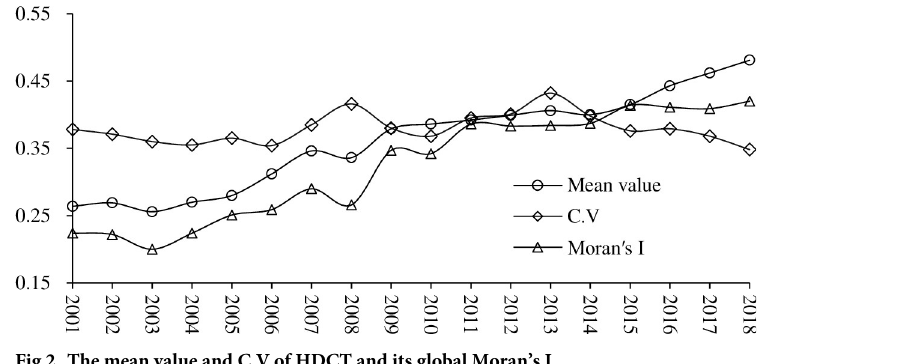
Fig 2. The mean value and C.V of HDCT and its global Moran’s I.